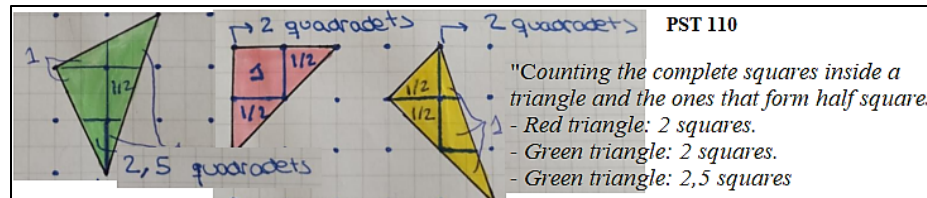
Figure 13. Example of a resolution process followed by PST 110.